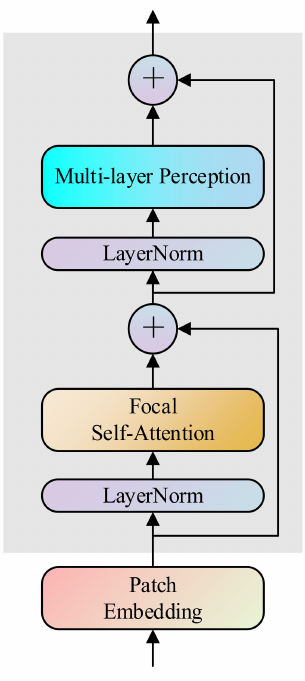
Figure 3. The architecture of the Focal Transformer fusion